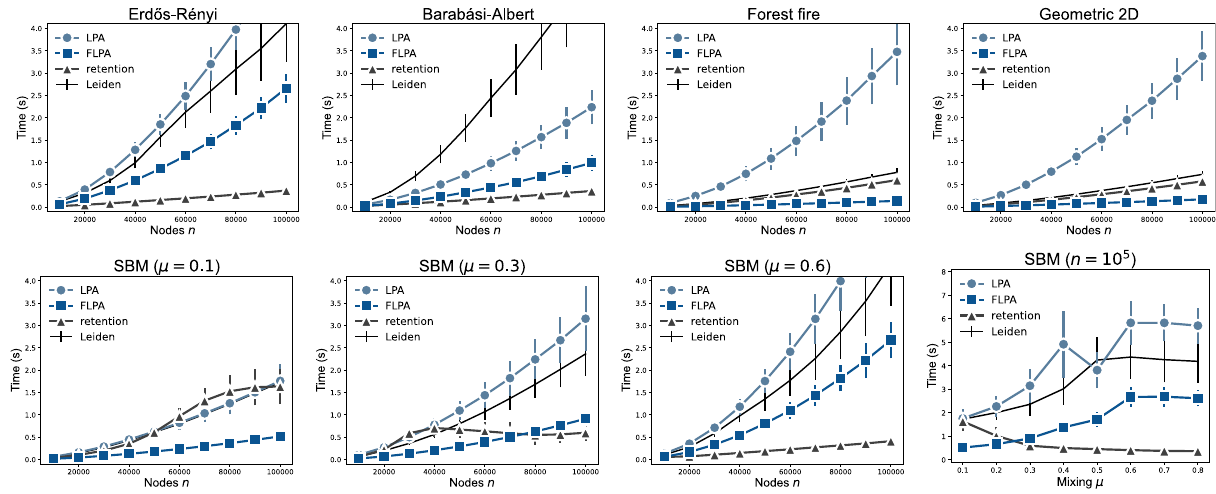
Figure 1. Algorithm runtime for synthetic networks with increasing number of nodes n and the average degree � k � = 10 . (top) Erdős-Rényi random graphs, Barabási-Albert scale-free graphs, forest fire graphs with burning probability 0.5 and two-dimensional geometric graphs with connection radius block model graphs with 100 groups and mixing parameter µ